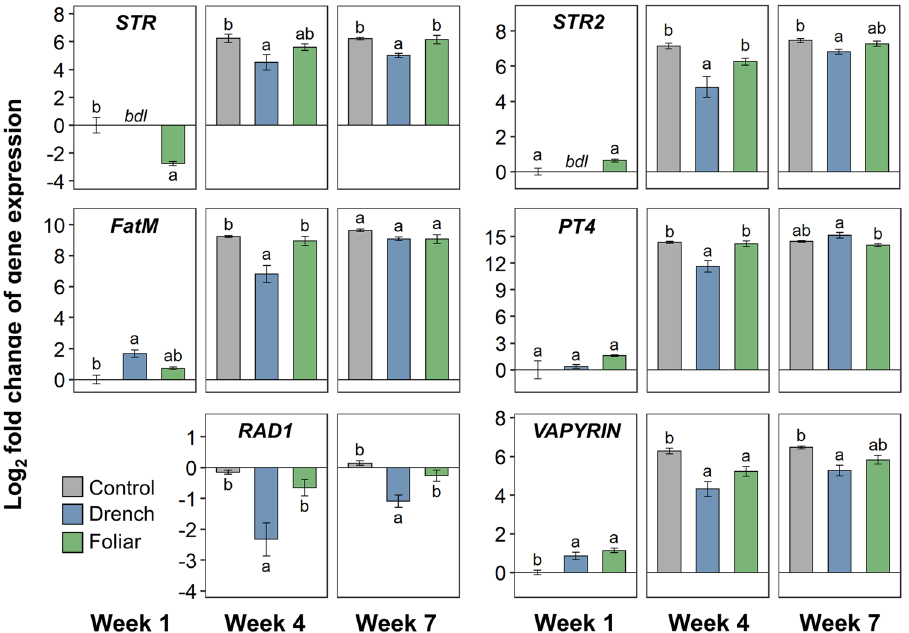
Figure 8. Expression of STR , STR2 , FatM , PT4 , RAD1 , and VAPYRIN in M. truncatula roots at week 1, 4 and 7 following inoculation with R. irregularis , as labelled. Values are the log 2 fold change, ΔΔC q , compared to the control at week 1, or week 4 when expression was below detectable levels at week 1. Letters indicate Tukey’s post-hoc test significance groups, α = 0.05, following analysis of variance per week; bdl below detectable